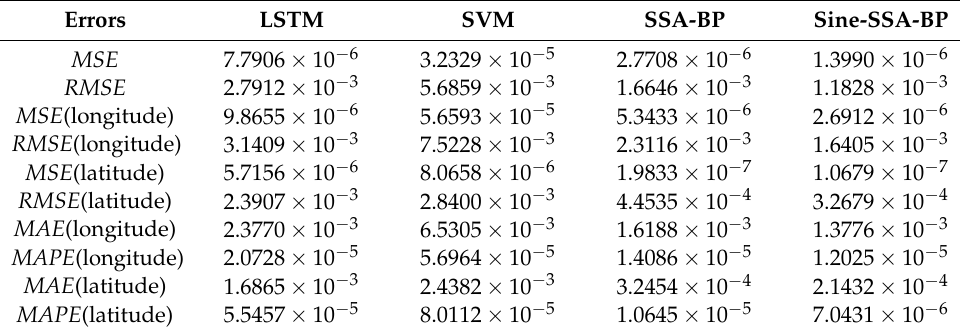
Table 2. Comparison of different model errors.